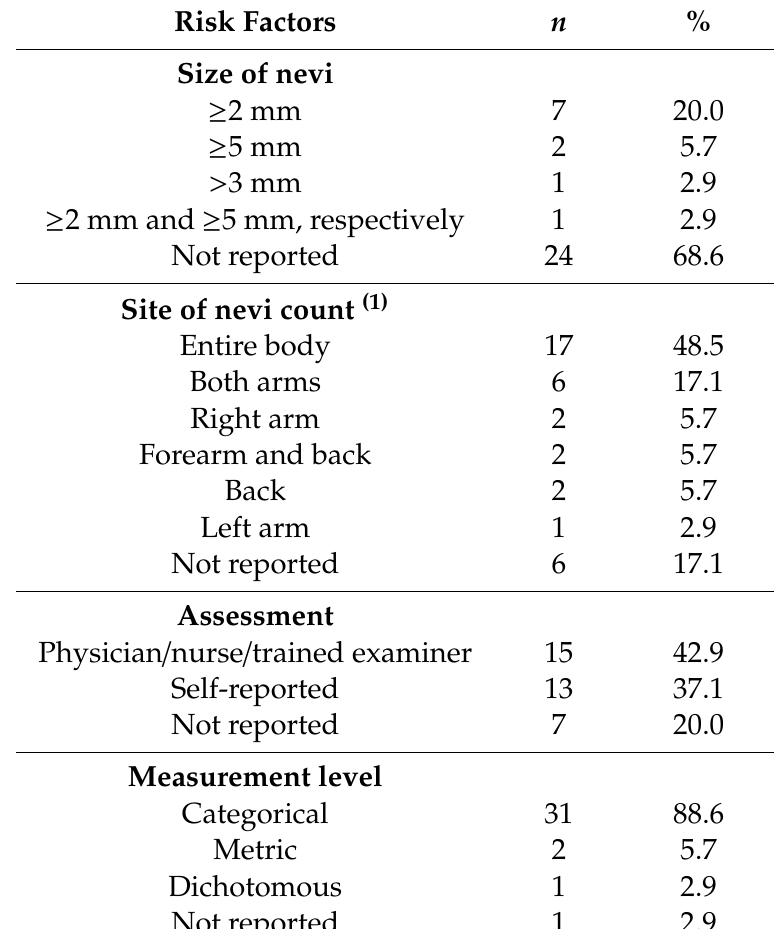
Table 2. Heterogeneity of the risk factor nevi in risk prediction models for melanoma regarding four aspects: minimum size of nevi to be counted, body area of nevi count, type of nevi assessment, and measurement level ( n = 35